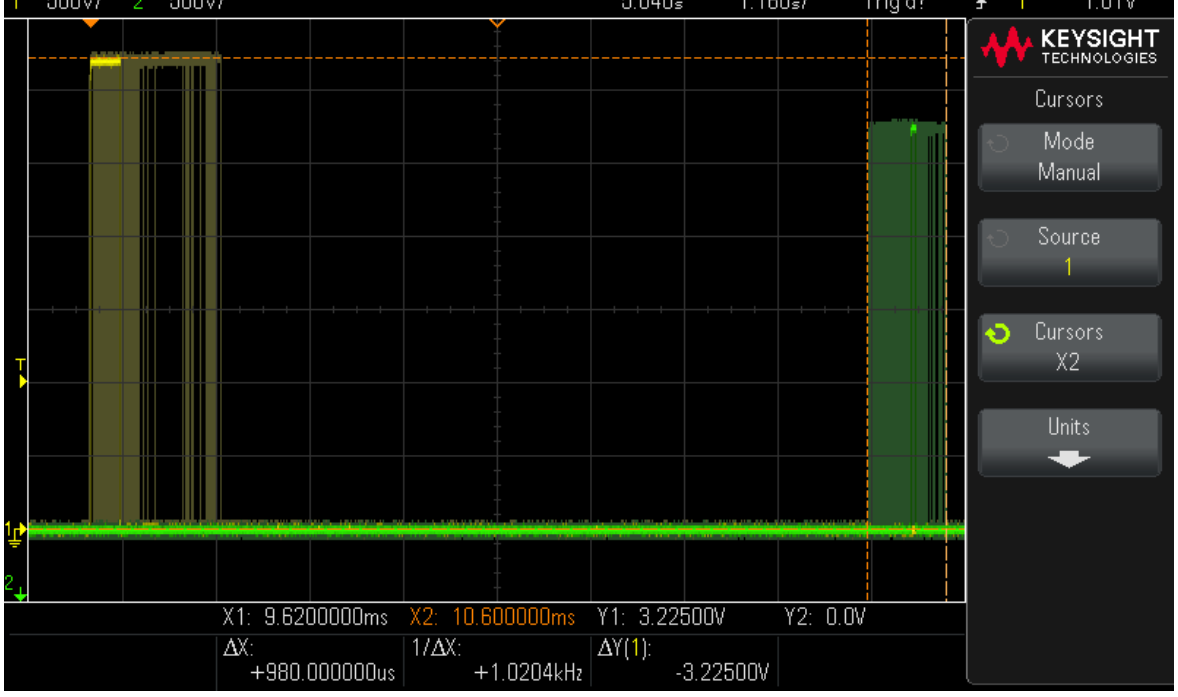
Figure 11. Minimum and maximum latency for a broadcast measurement command frame.